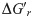
The top three pathways found by AGPathFinder in the search of L-serine biosynthesis in KEGG when ψ(Sc,Td) = ψ(false,true) (these three pathways are represented by p1, p2 and p3 respectively).Rectangles represent reaction edges, and the data in parentheses denote the value ΔG′r of reaction and the compound similarity respectively.